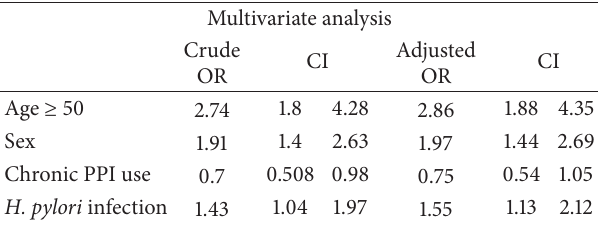
Table 2: Multivariate analysis of risk factors affecting development of adenomatous polyps.